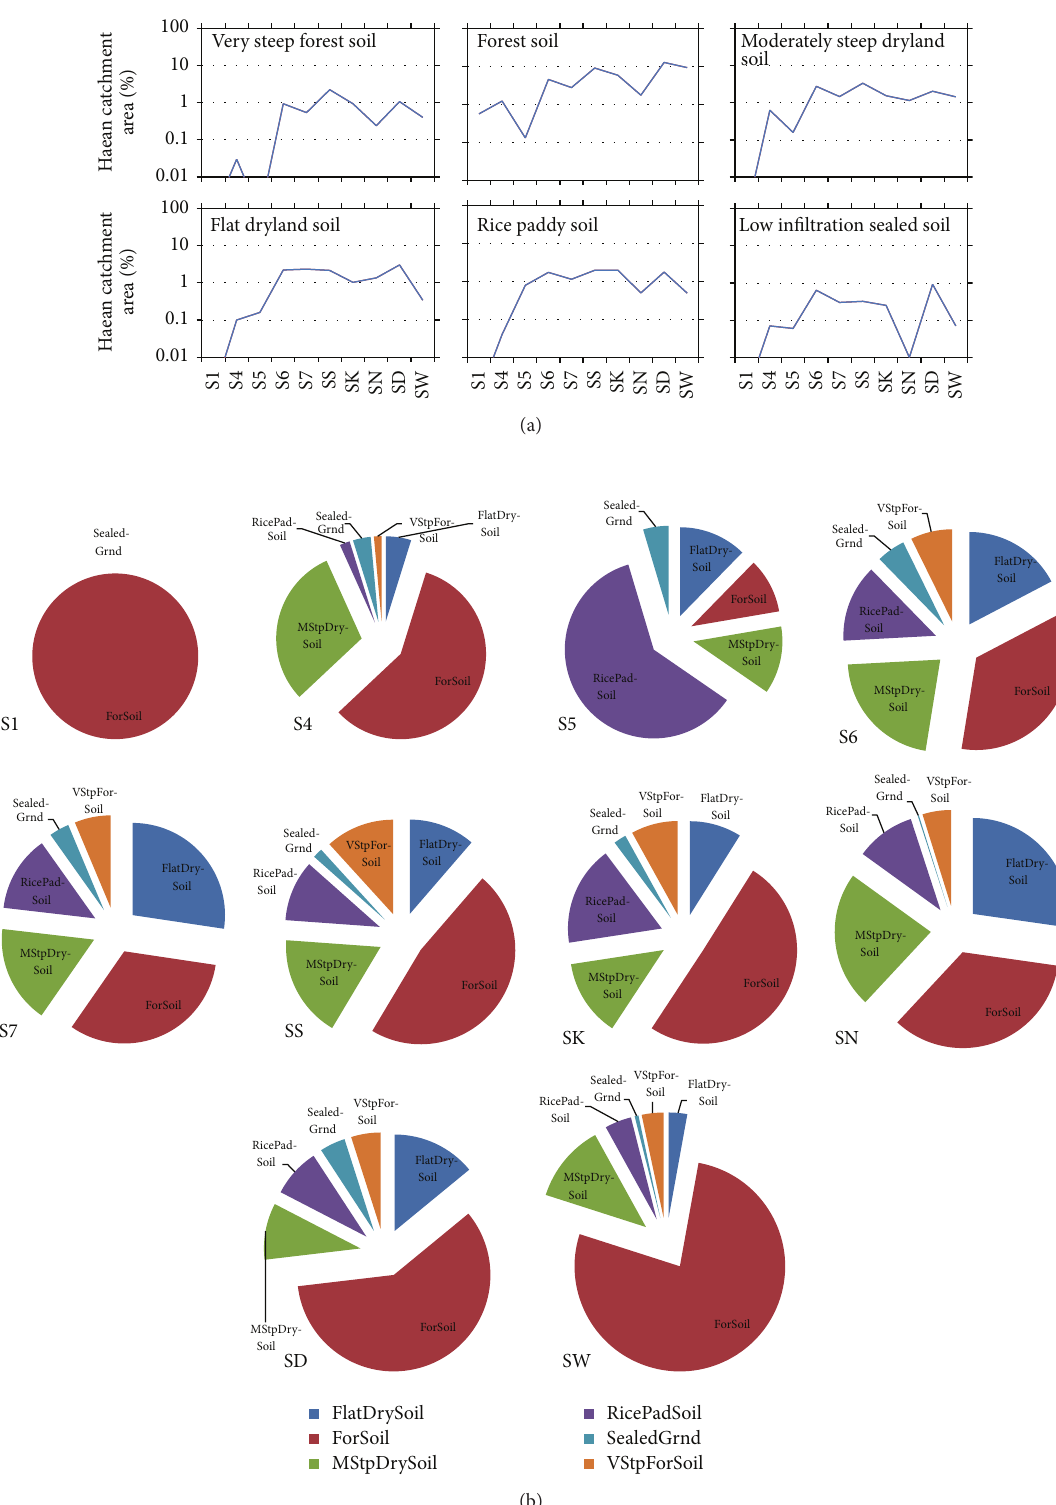
Figure 9: (a) Percentage of the Haean catchment soil distribution for each of the monitoring location drainage areas. The soil classification was aggregated to six heterogeneous soil types. (b) Soil distribution for each of the surface water monitoring location drainage